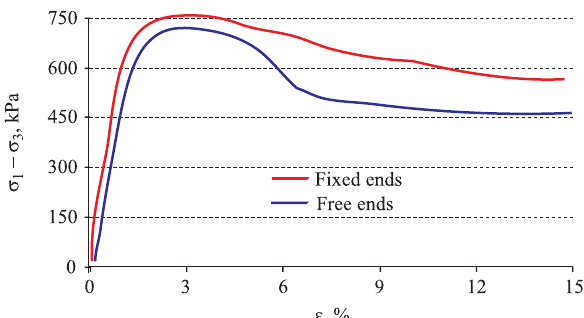
Fig. 2. Stress-strain graph of dense sand, when